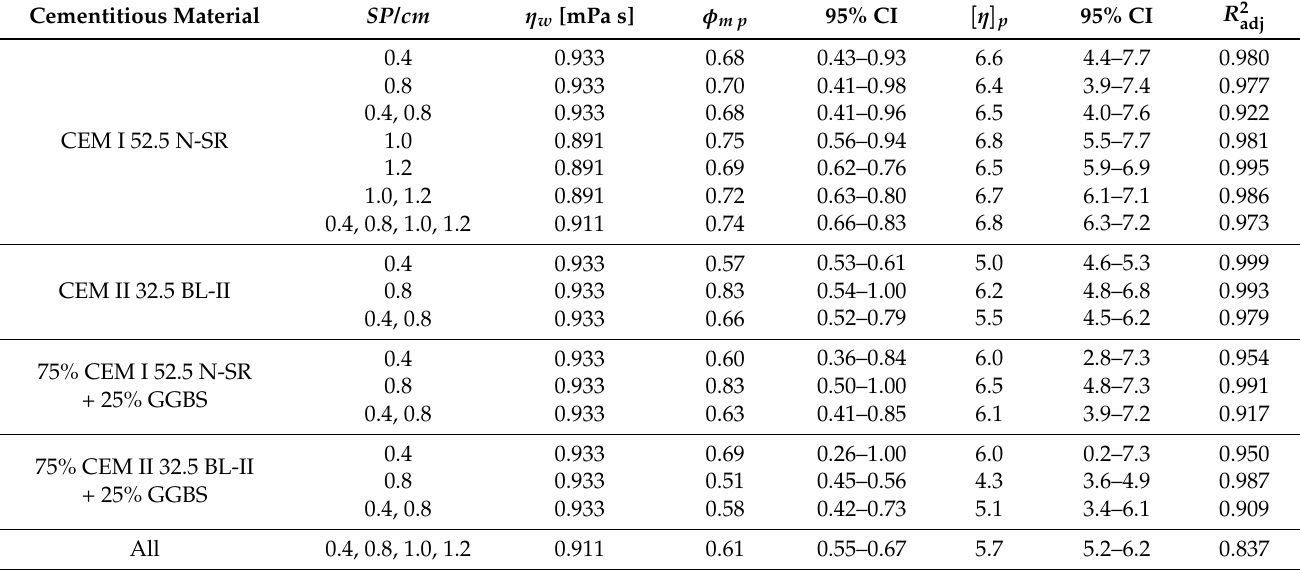
Table 1. Values of φ m p and [ η ] p calculated in cement pastes [5]. Average range in rotational rheometry: 0–600 s − 1 . CI stands for confidence